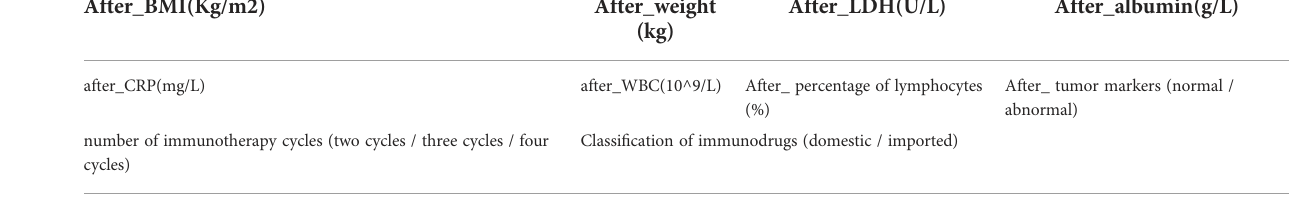
TABLE 8 Clinicopathological information converged with the before_rad_data.